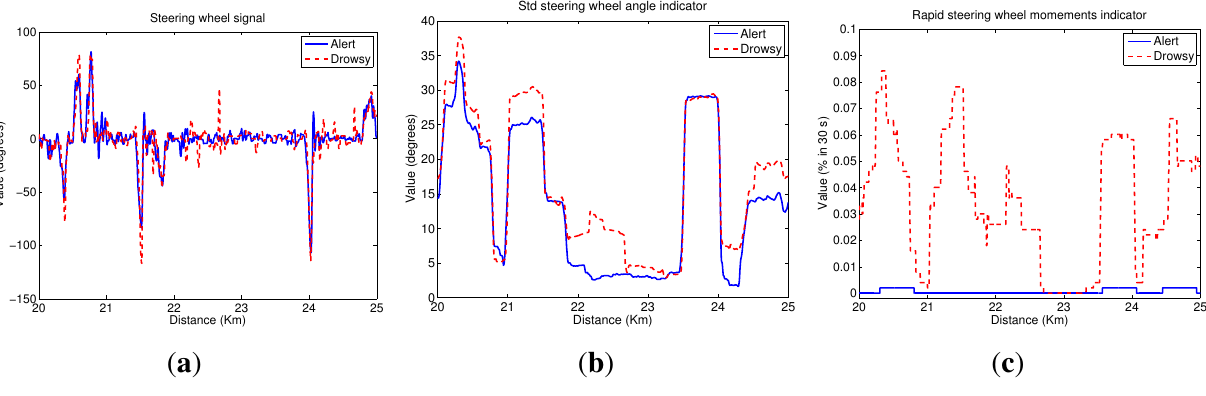
Figure 6. Steering wheel indicators. ( a ) Steering wheel signal; ( b ) the steering-wheel angle ( ST D sw ) and ( c ) rapid steering-wheel movement ( RSW M opti ).